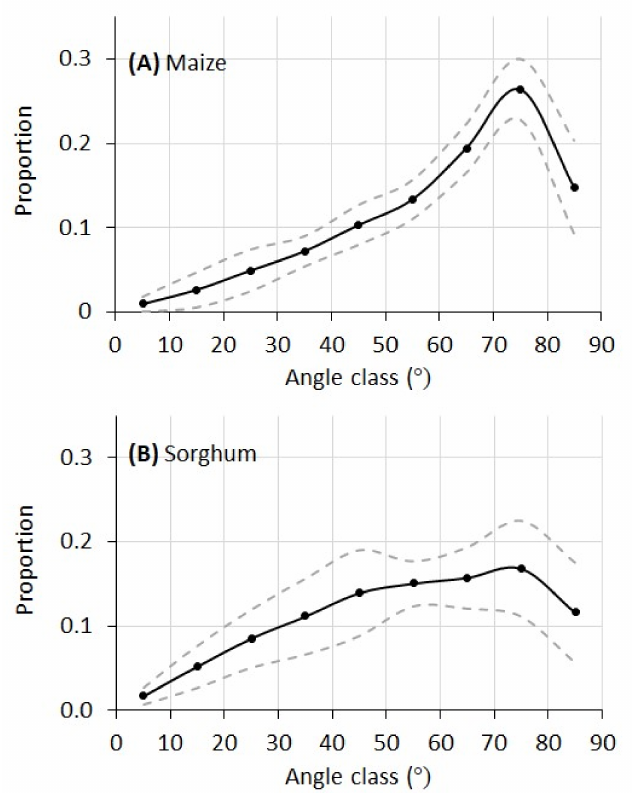
Figure 9. Leaf angular distribution of the ten maize plants and ten sorghum plants derived from their 3D leaf surface model. Solid line is the average proportion and the dashed lines are one standard deviation from the